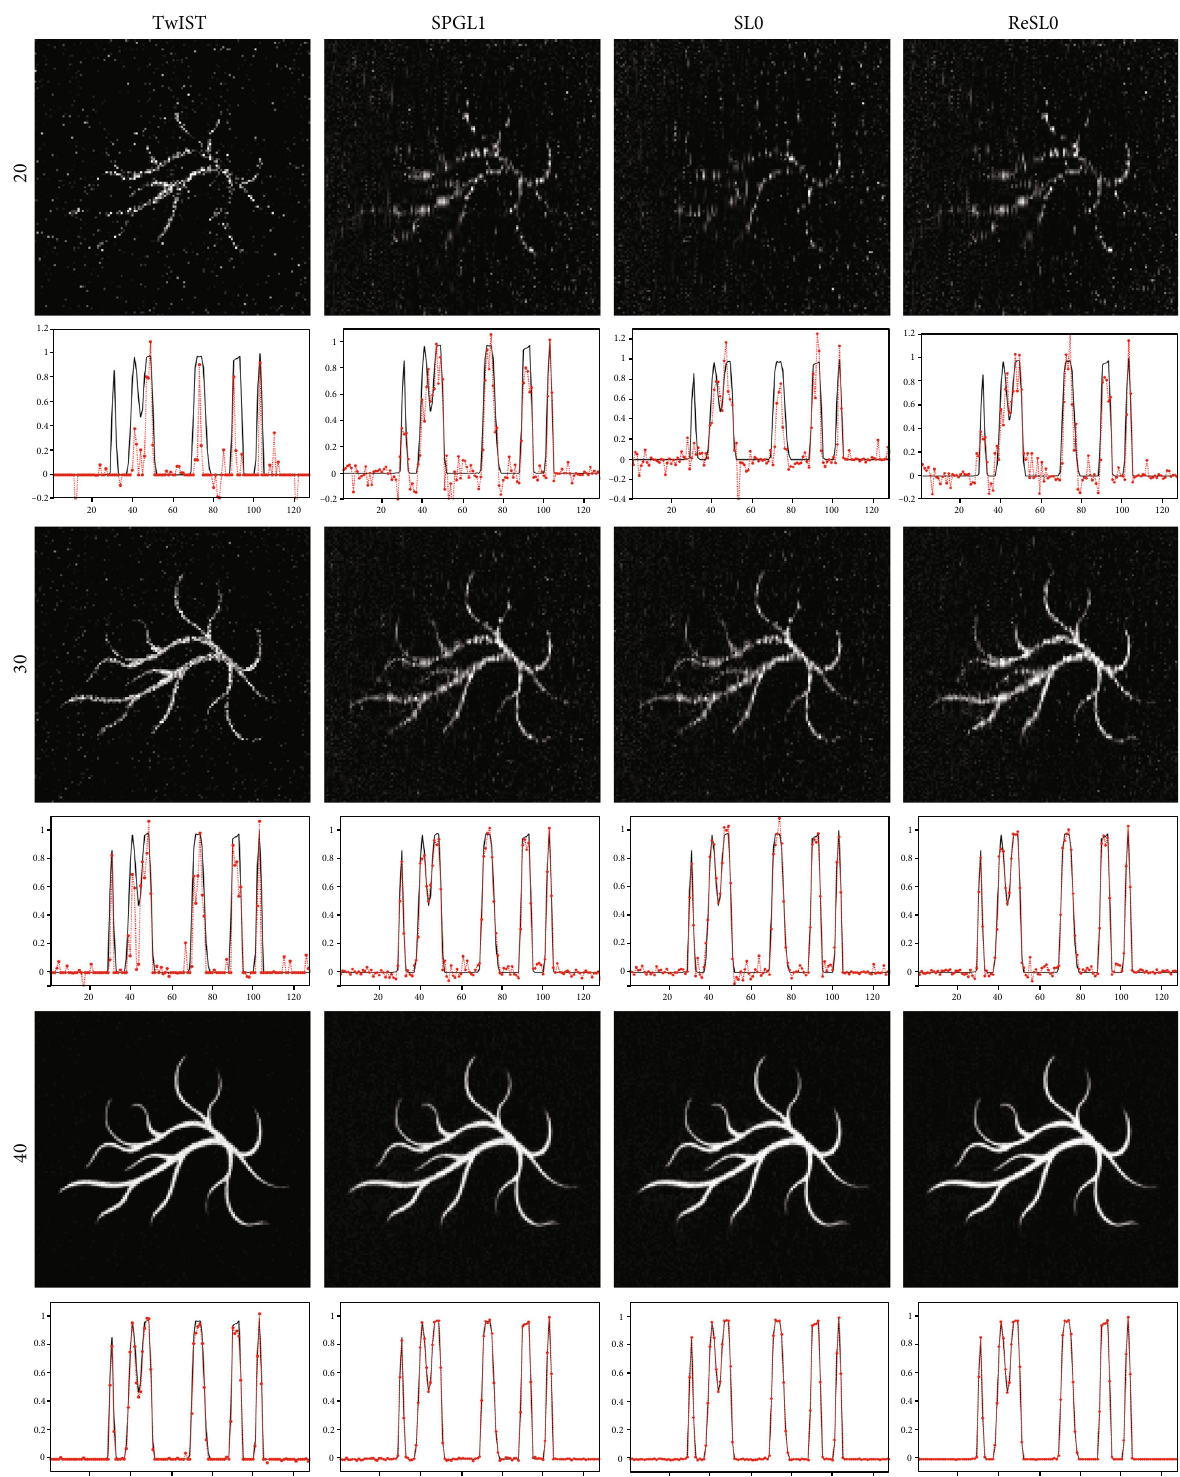
Figure 3: Reconstruction results of the blood vessel phantom. The fi rst to the third rows are the reconstruction images with 20-view, 30-view, and 40-view that are uniformly distributed at a 360 ° curve. The fi rst to the fourth columns show the results of TwIST, SPGL1, SL0, and ReSL0